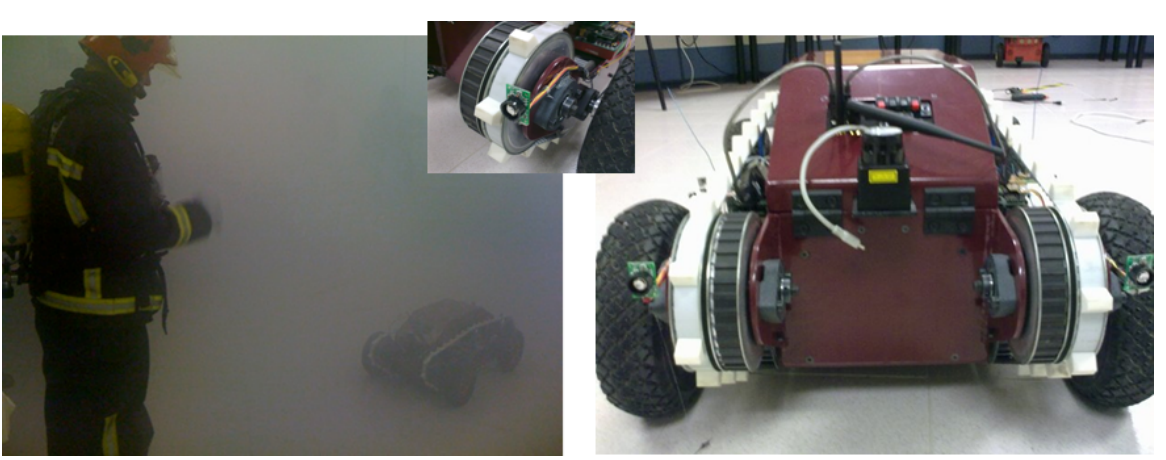
Guardian robot following a firefighter using a combination of radio and ultrasonic